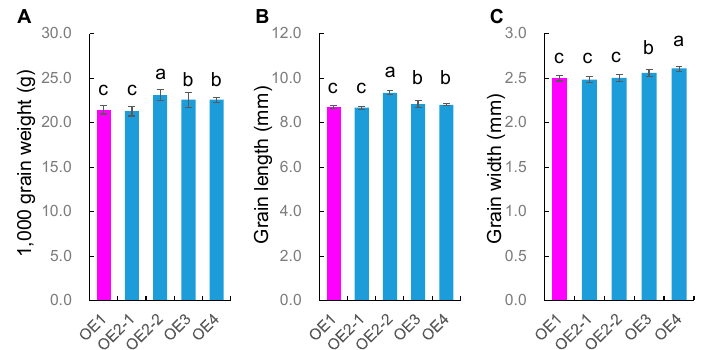
Figure 3. Phenotypic performance of OsMADS56 driven by an Actin promoter. ( A ) Thousand-grain weight (g). ( B ) Grain length (mm). ( C ) Grain width (mm). Values are given as the mean ± SD ( n = 24 for OE1, OE3 and OE4; n = 21 for OE2-1; n = 18 for OE2-2). Values with different letters are significantly different at p < 0.05 based on Duncan’s multiple range